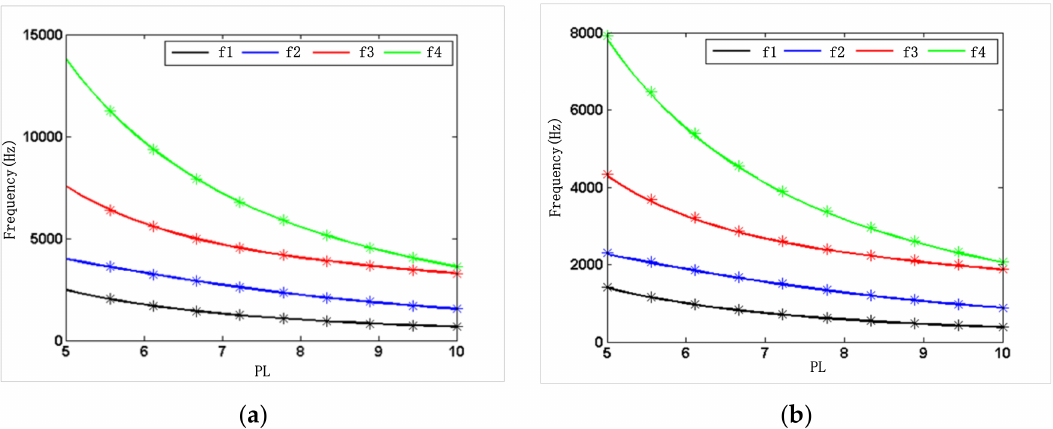
Figure 5. Theoretical and numerical frequencies of the resonator at a fixed-width ratio: ( a ) silicon; ( b ) steel.